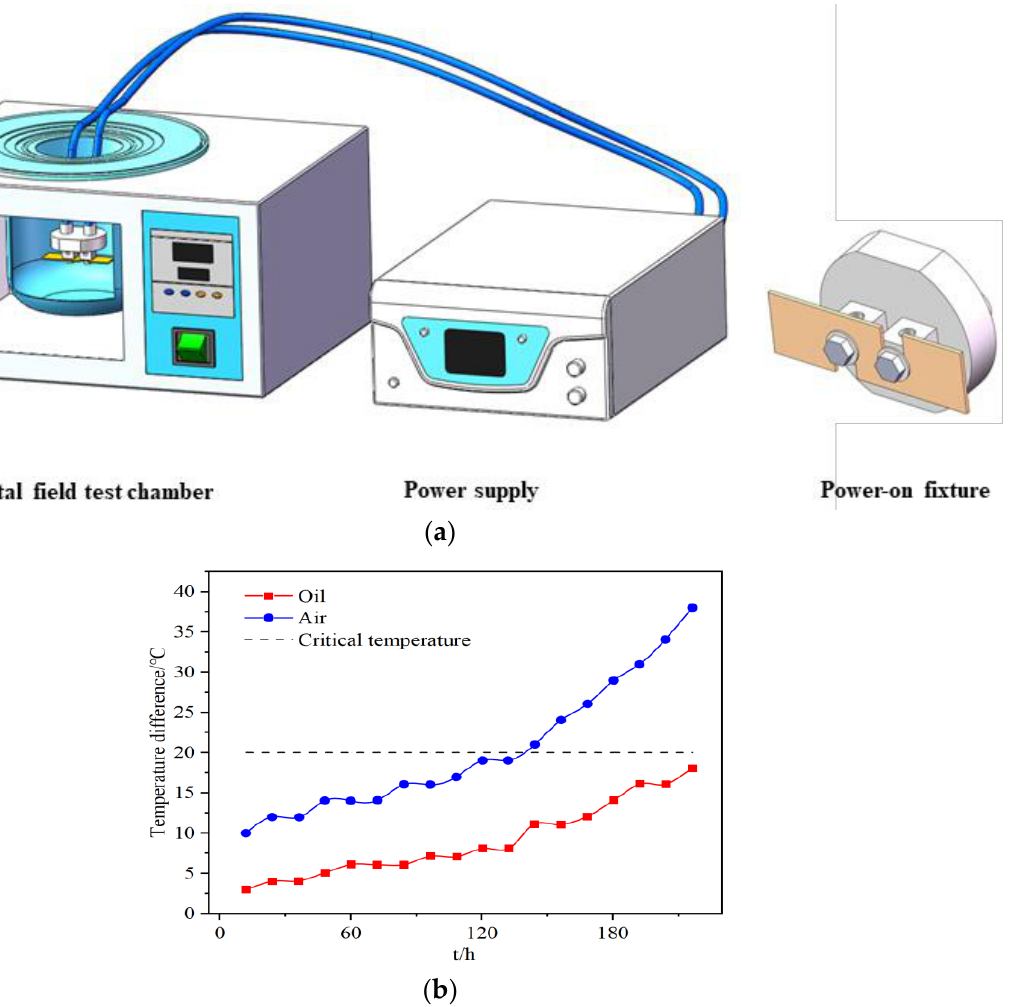
Figure 2. Electromigration device and testing. ( a ) Electromigration device. ( b ) Temperature difference between the two electrodes of the solder joints.